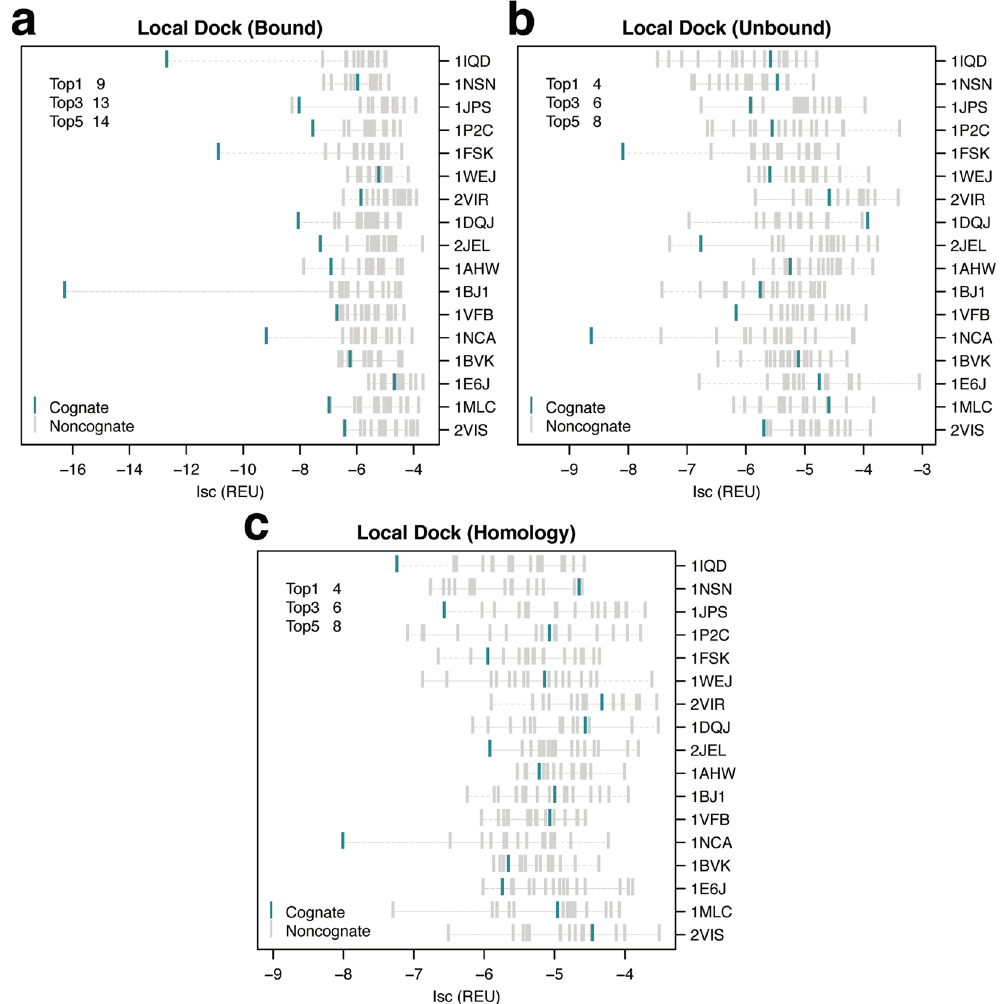
Figure 5. Ranks of cognate complexes among local dock antibody–antigen models. Interface scores (Isc) of the top-scoring cognate (turquoise) and non-cognate (grey) local dock models for ( a ) bound, ( b ) unbound, and ( c ) homology antibody–antigen complexes. Each row indicates a single antigen represented by the PDB ID of the bound complex. Antigens are sorted based on decreasing experimental binding affinities for their native antibodies (top to bottom). The top left corner shows the number of antigens where the cognate antibody complex is ranked in the top 1, 3, and 5 top-scoring cognate and non-cognate models generated for the